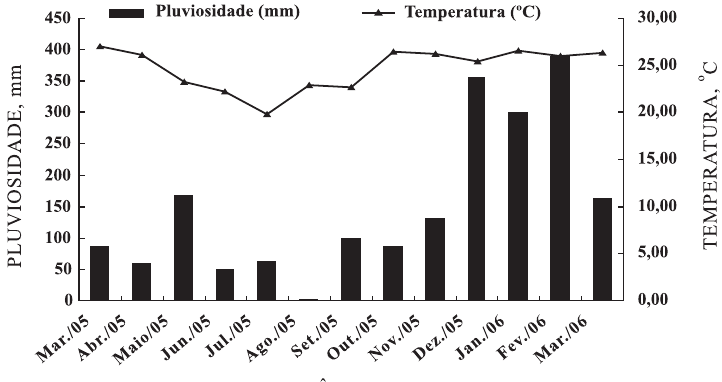
Figura 1. Médias de temperatura e precipitação para o período do experimento, compreendido entre março de 2005 e abril de 2006. Fontes: UNESP